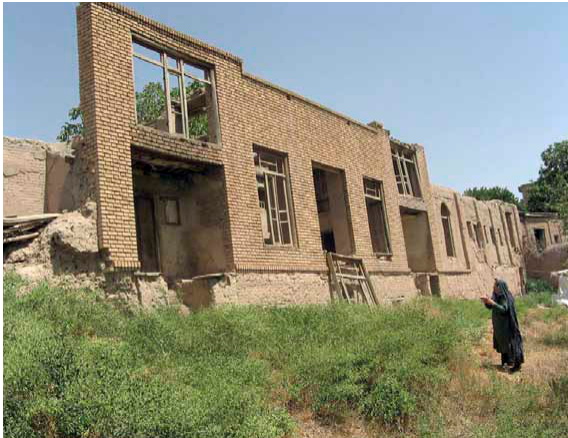
fig. 5. Hashemi house: a sample of buildings in group